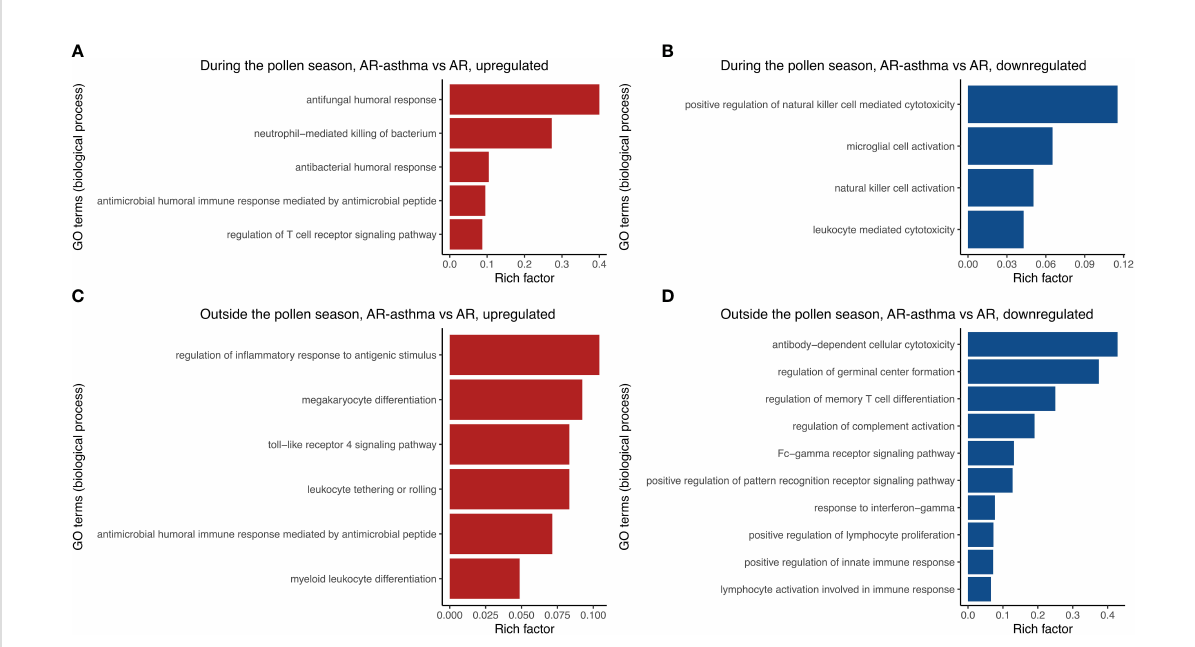
FIGURE 2 Immune-related GO terms enriched from up-regulated DEGs between the AR-asthma group and AR group during the pollen season (A) . Immune- related GO terms enriched from down-regulated DEGs between the AR-asthma group and AR group during the pollen season (B) . Immune-related GO terms enriched from up-regulated DEGs between the AR-asthma group and AR group outside the pollen season (C) . Immune-related GO terms enriched from down-regulated DEGs between the AR-asthma group and AR group outside the pollen season (D) . AR, allergic rhinitis; DEGs, differentially expressed genes; GO, gene